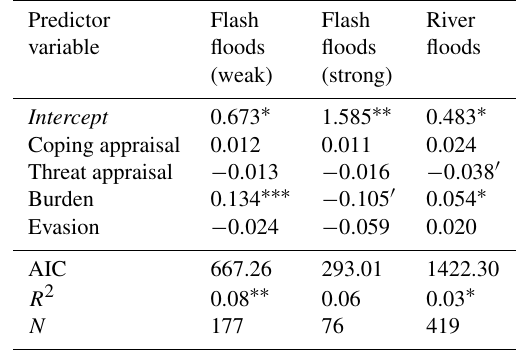
Table 2. Coefficients of the negative binomial logistic regression models for weak flash floods, strong flash floods and river floods, with the psychological indicators as predictor variables and the planned precaution indicator as the response variable. Predictor Flash Flash River variable floods floods floods (weak)